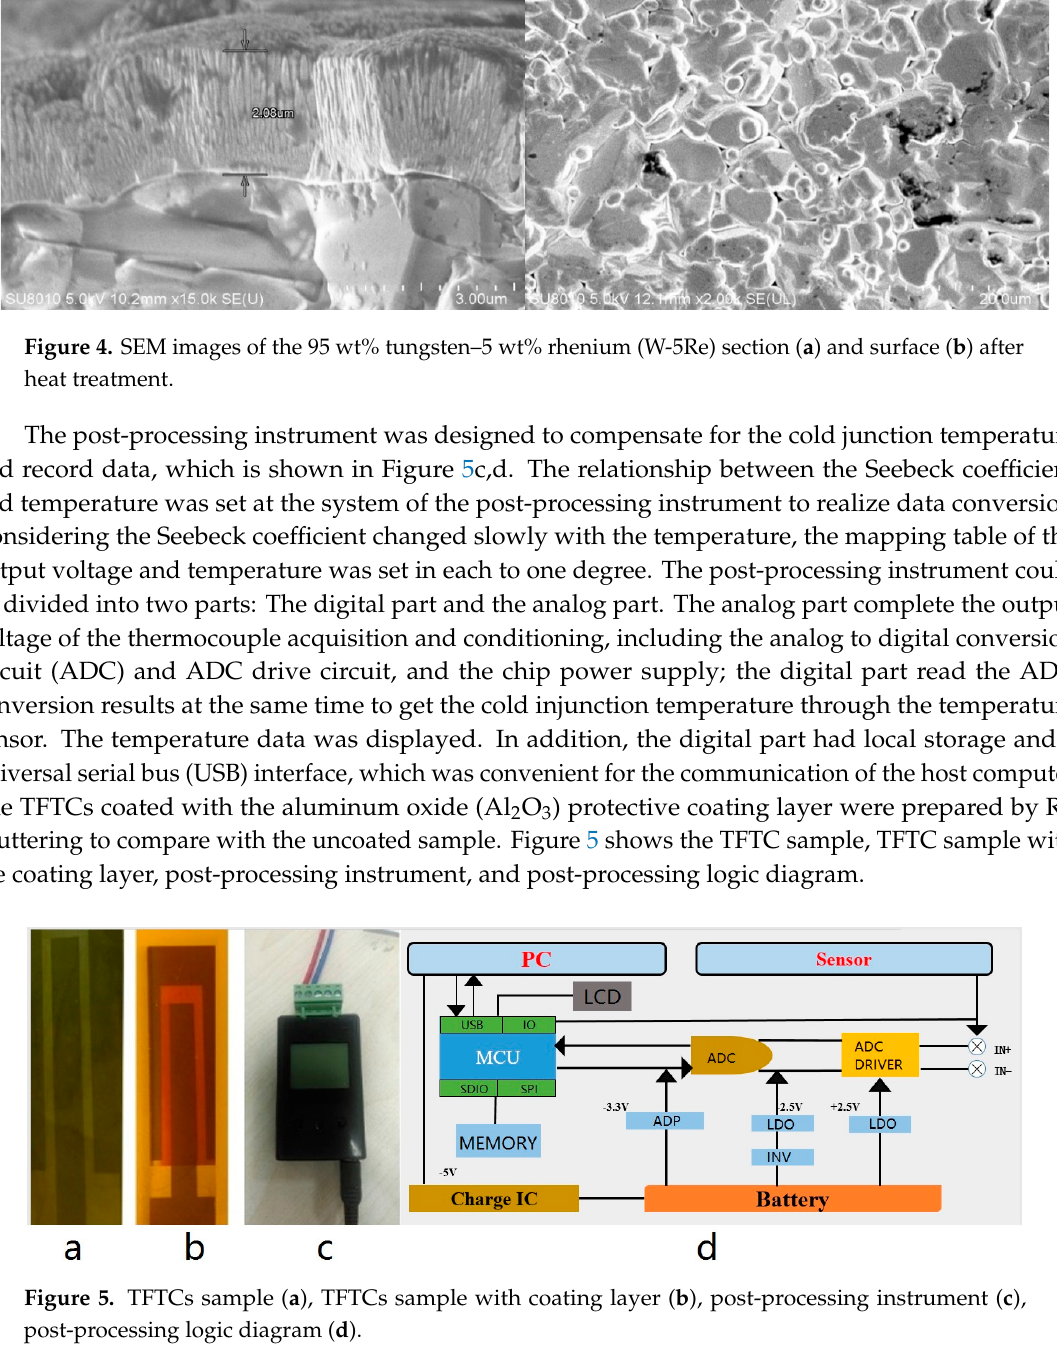
Figure 3. The relationship between thermal stress and thermoelectric characteristics by finite element analysis (FEA).